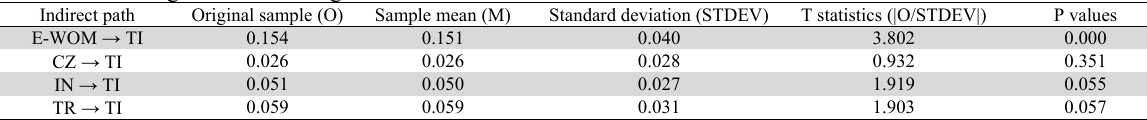
Indirect Effects Significance